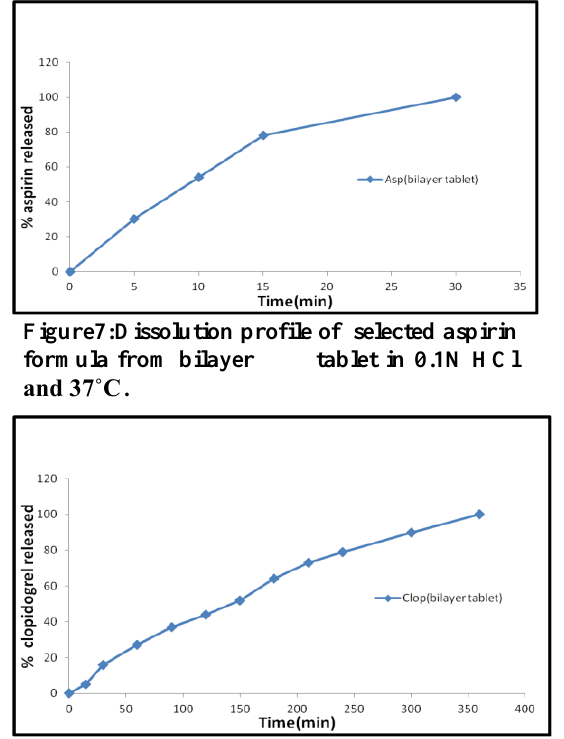
Figure8:Dissolution profile of selected clopidogrel formula from bilayer tablet in 0.1N HCl and37˚C